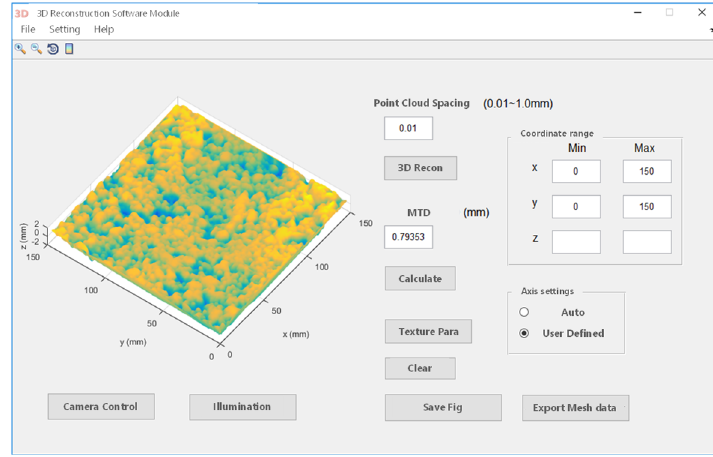
Figure 8. The 3D reconstruction software module. Table 2. The MTD values for three kinds of asphalt pavement.